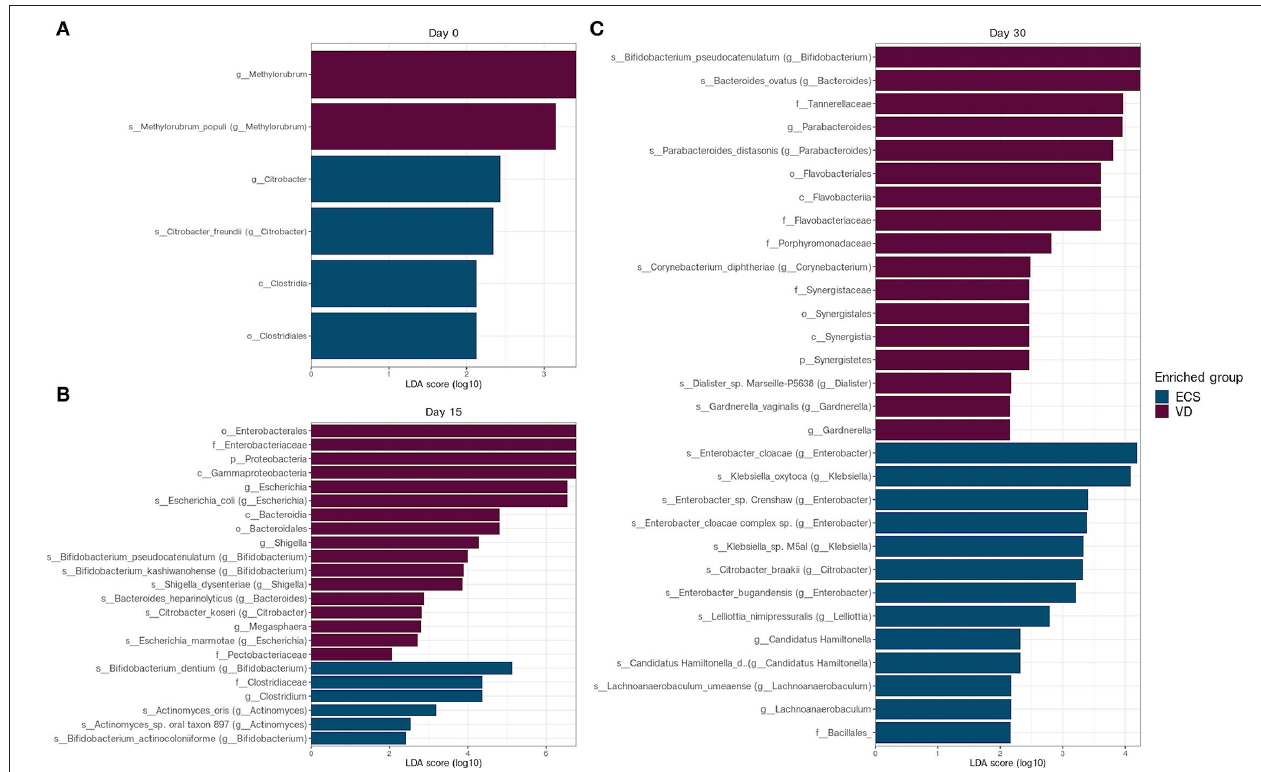
FIGURE 4 | Differentially abundant taxa between ECS and VD newborns at each collection data. Linear discriminant analysis effect size (LEfSe) analysis of metagenomic sequences from ECS and VD newborn stool samples at Day 0 (A) , Day 15 (B) , and Day 30 (C) . The blue shaded bars indicate the taxa enriched in the microbiome of VD newborns. The purple shaded bars indicate the taxa enriched in the microbiome of ECS newborns. The prefixes “p,” “c,” “o,” “f,” “g,” “s,” and “s” indicate the annotation levels of phylum, class, order, family, genus, species, and strain,